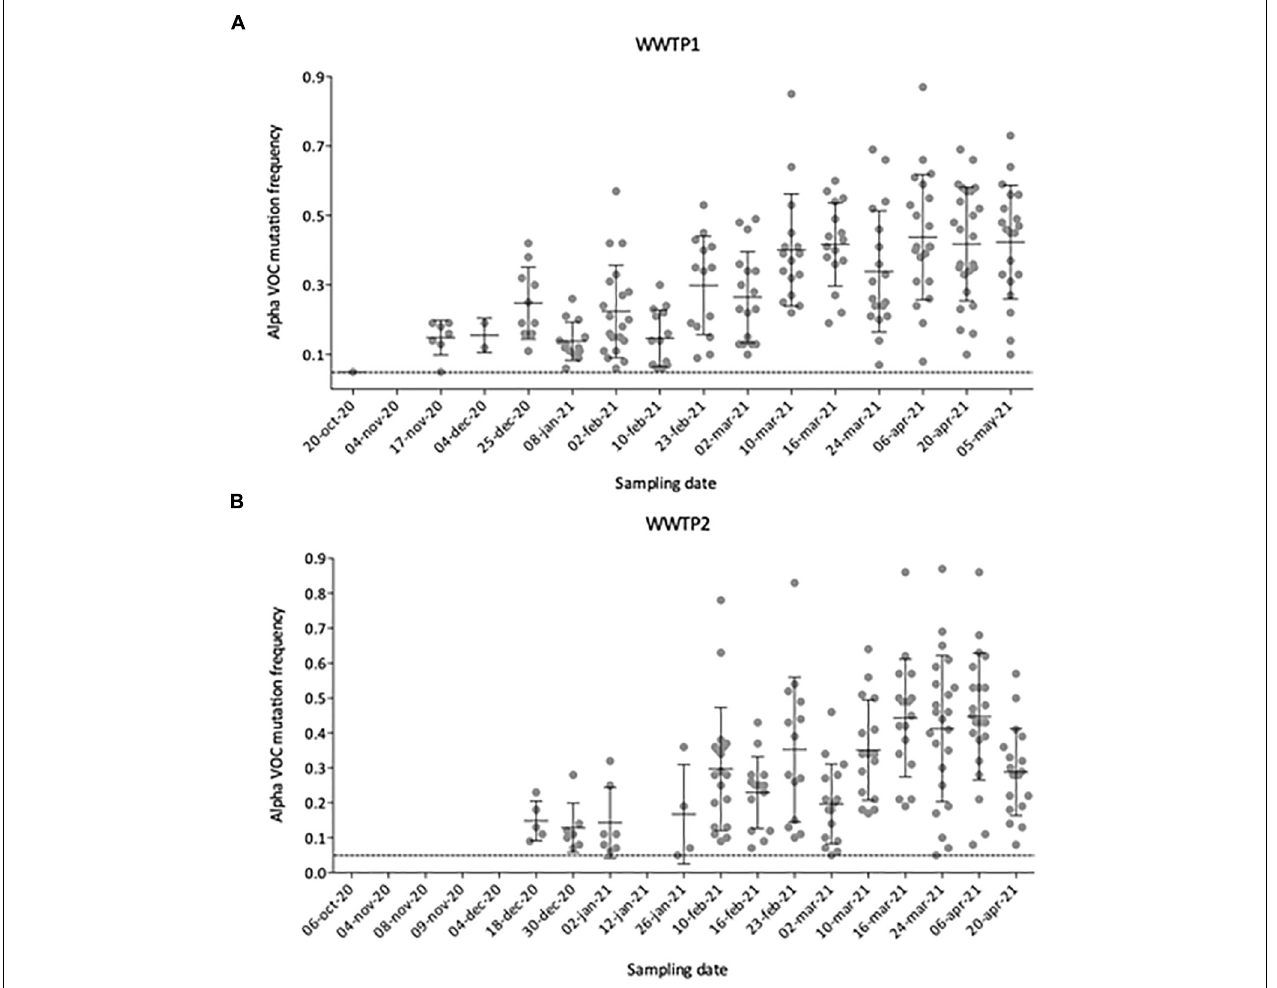
FIGURE 6 | Number and individual frequencies (dots) of SARS-CoV-2 Alpha VOC over time in 35 raw wastewater samples from WWTP1 (A) and WWTP2 (B) , with median frequency (horizontal lines) and standard deviation (error bars). Only mutation with frequencies above 5% (dotted line) were considered.